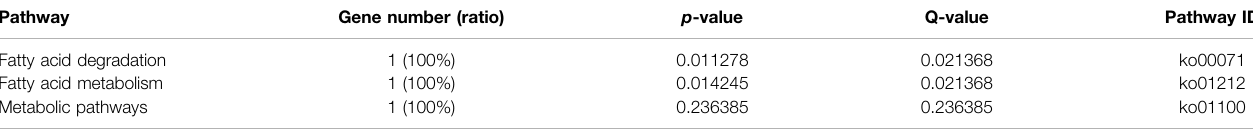
TABLE 5 | KEGG enrichment for strong positive select genes by comparing Zeugodacus cucurbitae (Coquillett) and Ceratitis capitata (Wiedemann). Pathway